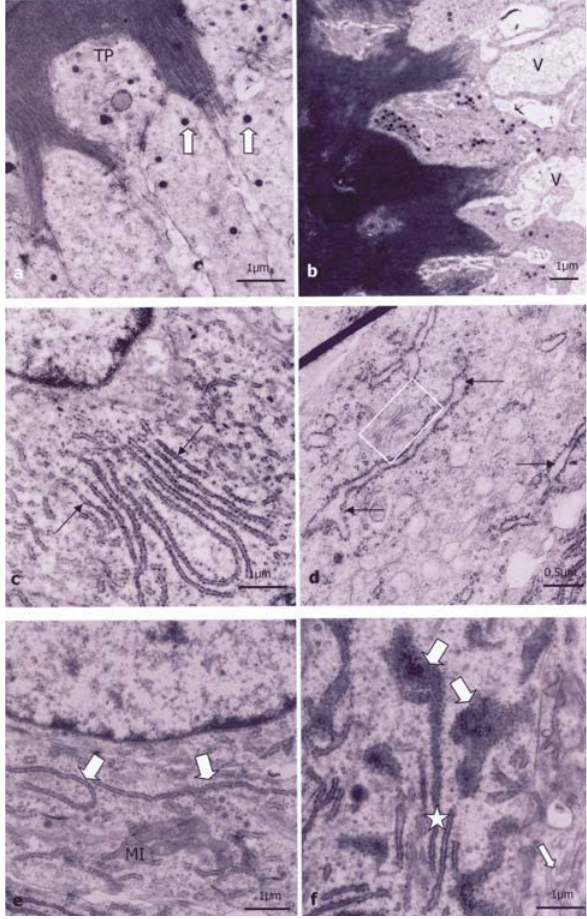
FIGURE 2 (a-f)- Ultrathin sections of the secretory ameloblast of rat incisor buds. a) Some small secretion granules (arrows) at the apical region and in the Tomes’ process (TP) region of the 0 ppm group at the age of 0 days, b) Large vacuoles (V) in the TP region of the newborn rat from the 100 ppm group; c) In the middle region, homogeneous and parallelly distributed RER cisterns of the 0 ppm group at the age of 0 days, d) In supranuclear area, dilated RER cisterns (arrows) and small saccules of Golgi complex ( ) of newborn rat from the 100 ppm group; e) Preserved RER cisterns (large arrow) of the 7 ppm group at the age of 14 days, f) Preserved RER cisterns (star) and dilated RER cisterns filled with intracisternal material (big arrow), and Golgi complex saccules (small arrow) of